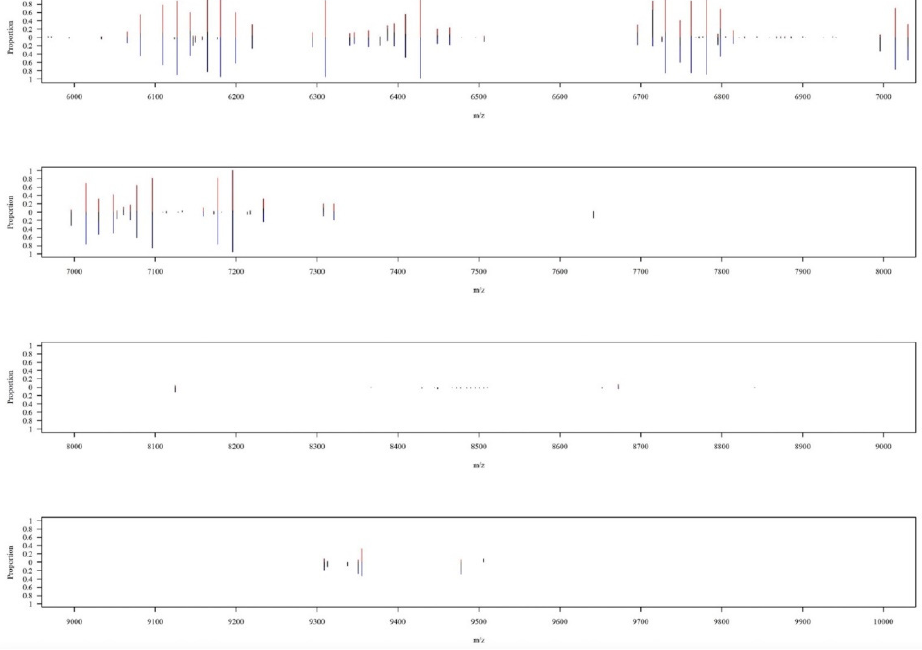
Figure 5. Zoomed- in view on MALDI–TOF spectrum over m / z 6000 to 10,000. A zoomed-in view over the range of m / z 6000 to 10,000. The x -axis represents the mass-to-charge ratio ( m / z ) from 6000 to 10,000. The y -axis means the proportion of occurring frequency in all corresponding isolates at specific peaks, while red lines represent M. massiliense , and blue lines represent M. abscessus . For example, at peak of m / z 9478, red line (i.e., M. massiliense ) appears less than 10% of subsp. massiliense isolates, whereas the blue line (i.e., M. abscessus ) shows the occurring frequency is about 30%.